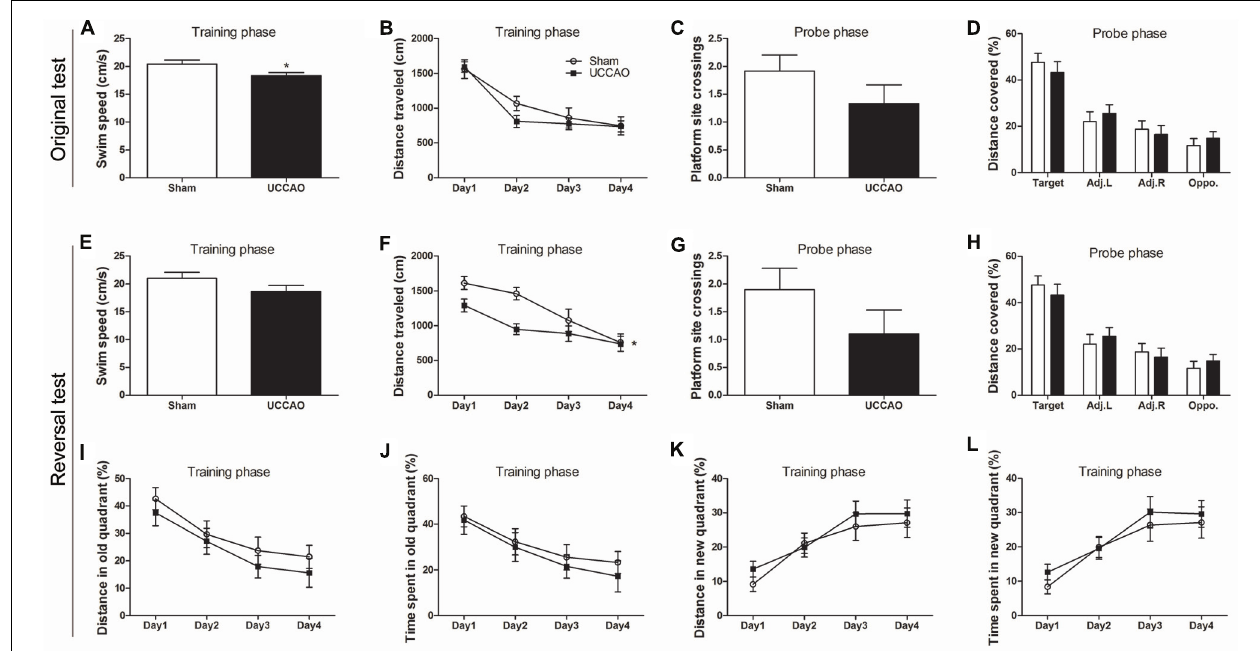
FIGURE 3 | Morris water maze tests of mice with CCH. Spatial memory of the mice was tested in the Morris water maze test (A–D) and the consecutive reversal test (E–L) .The average swim speed in the training phase (A,E) , the distance traveled to the hidden platform during training (B,F) , the number of the platform site crossings during the probe trial (C,G) , the percentage of